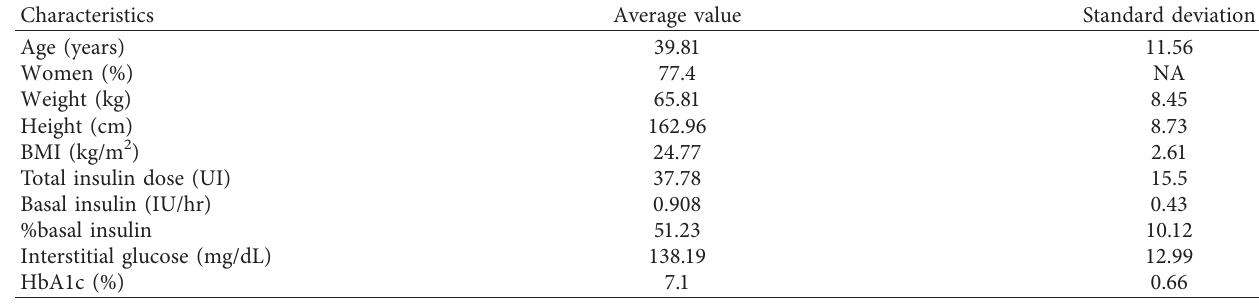
Table 1: Demographic data.